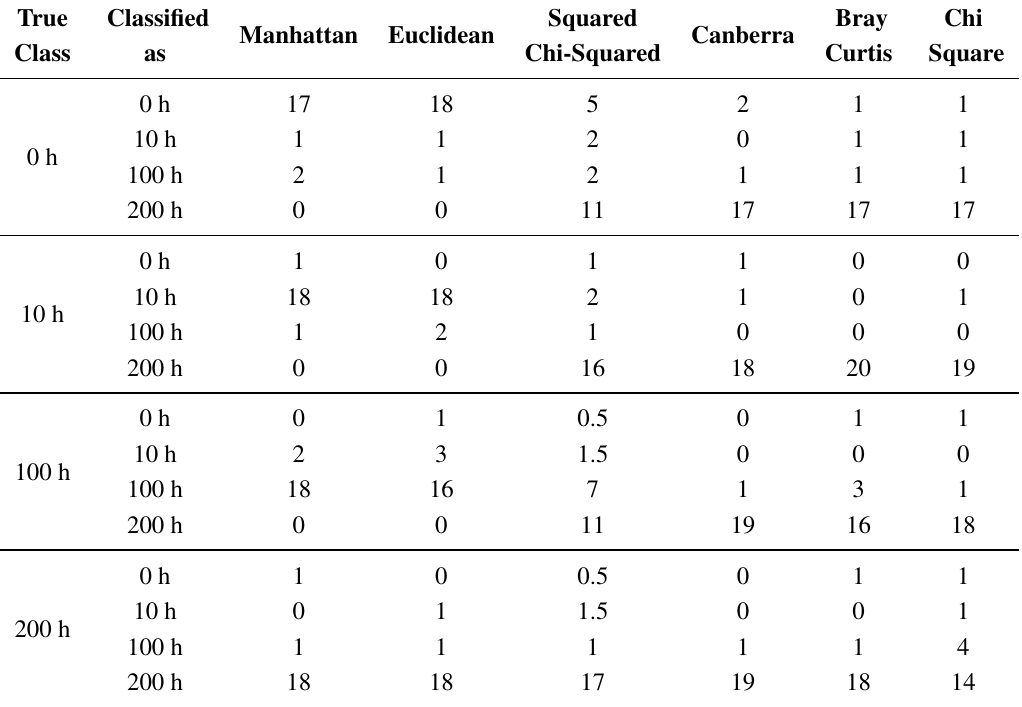
Table 2. Confusion matrix of the classification means for the 4-MHz frequency backscattered signals at 650 ◦ C.